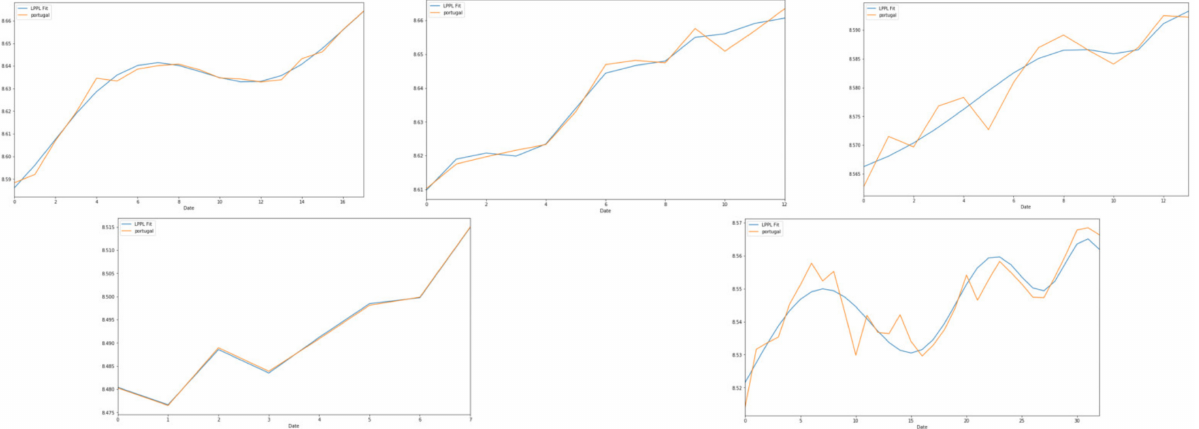
Figure A4. LPPL Signatures in the Portuguese Stock Exchange (PSI 20) 15 January 2015 to 14 January 2020. Log-periodic power law signatures in the Portuguese Stock Exchange.